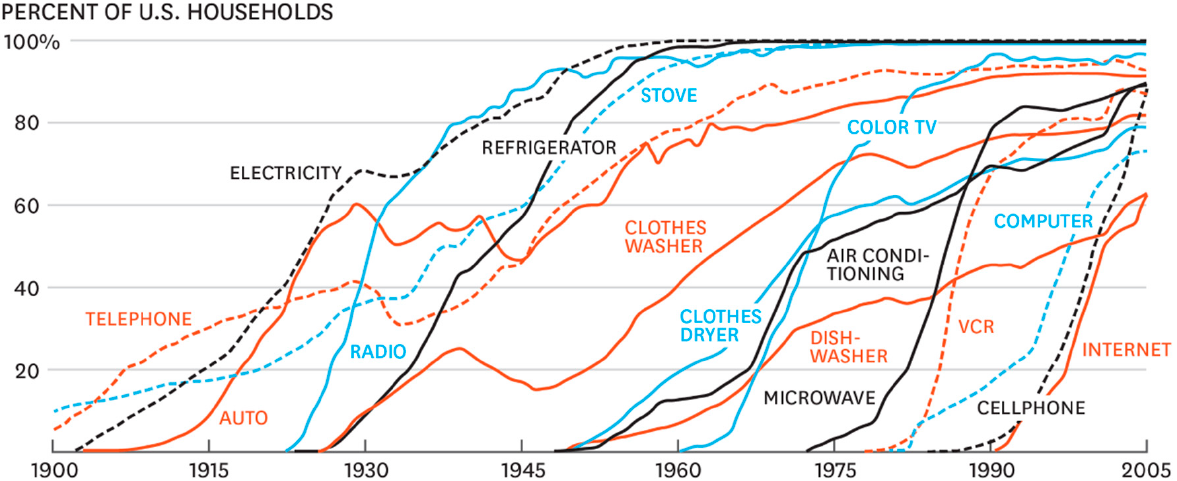
Figure 1. Consumption Spreads Faster Today. Source: W. Michael Cox and Richard Alm, “You Are What You Spend”, New York Times , 10 February 2008; graphic by Nicholas Felton (accessed on 15 January 2022).